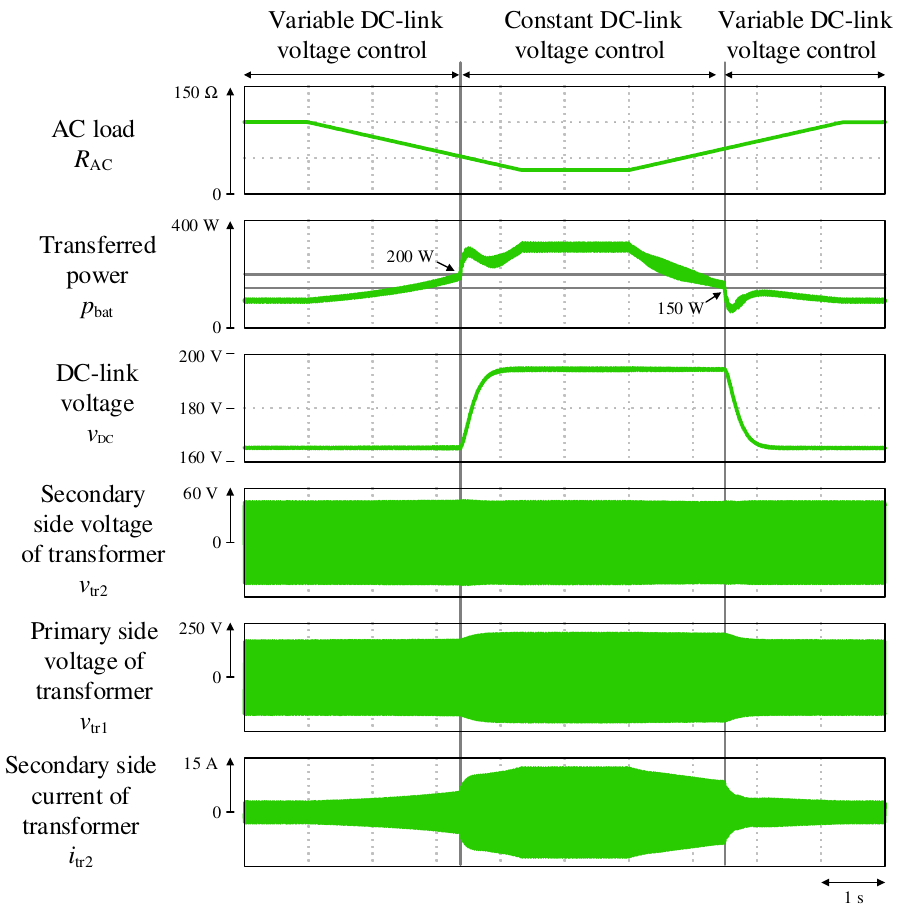
Figure 19. Simulation results for reference DC-link voltage switchover